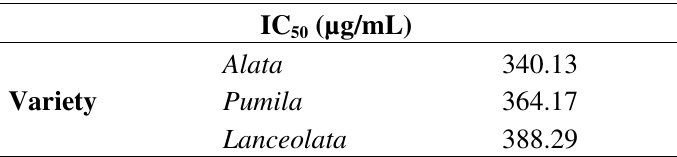
Table 3. DPPH free scavenging activities of the leaf part in all varieties of Labisa pumila. BHT and α -tocopherol were used as controls.